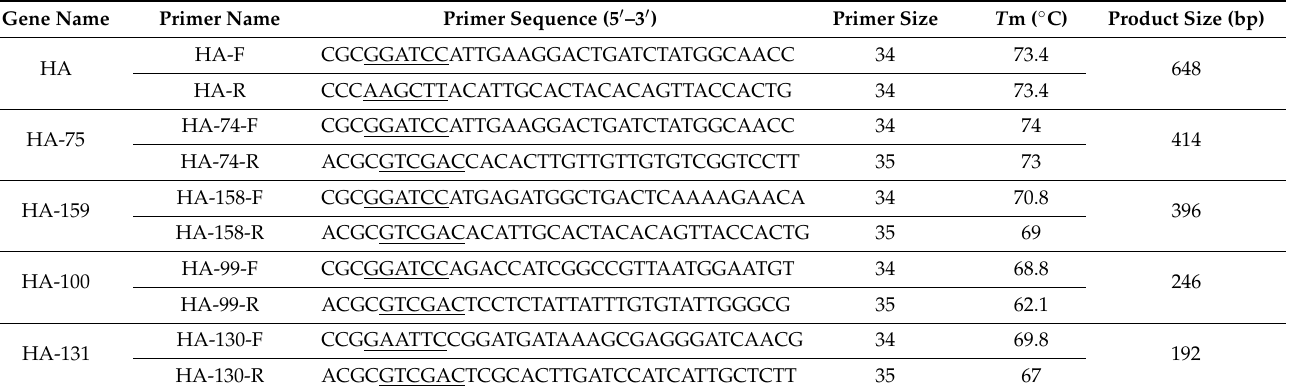
Table 1. Primers of the truncated HA gene for PCR